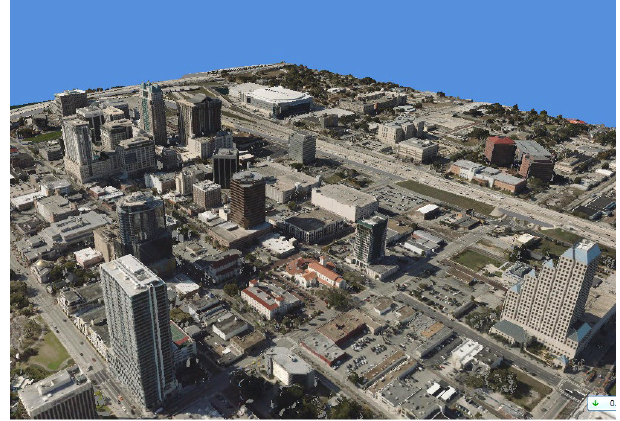
Figure 4. Another perspective view of 3D